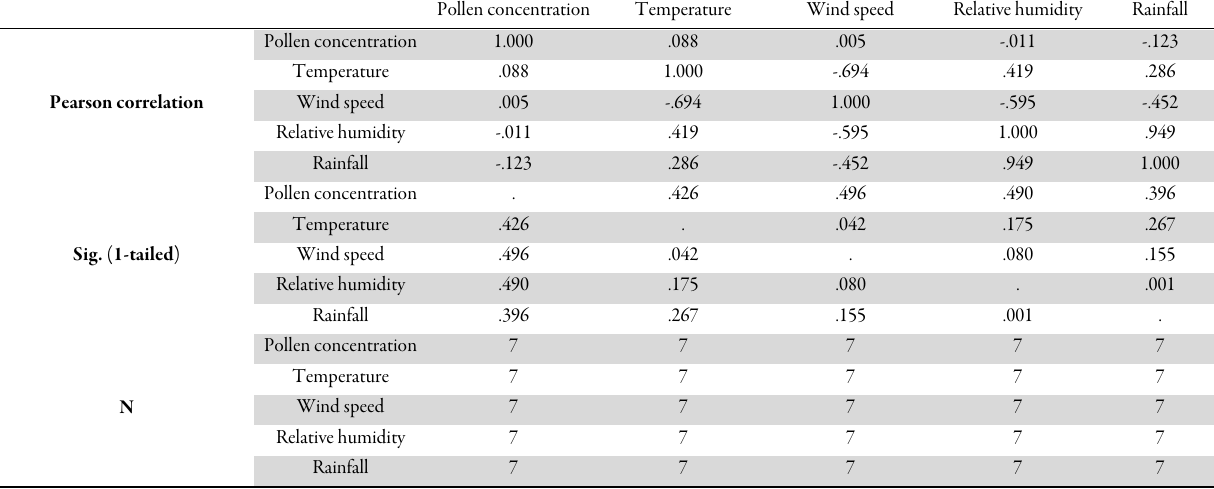
Table 7. Relationship between monthly pollen concentrations and values of mean meteorological parameters at the study site in Sokoto state at 95% confidence interval (P < 0.05)